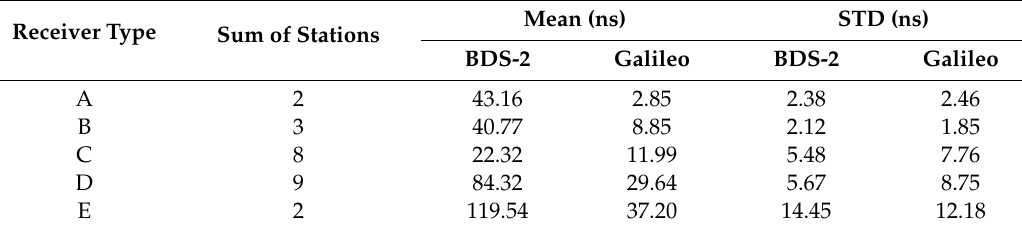
Table 1. Means and standard deviations (STDs) of the ISB for grouped receiver types.